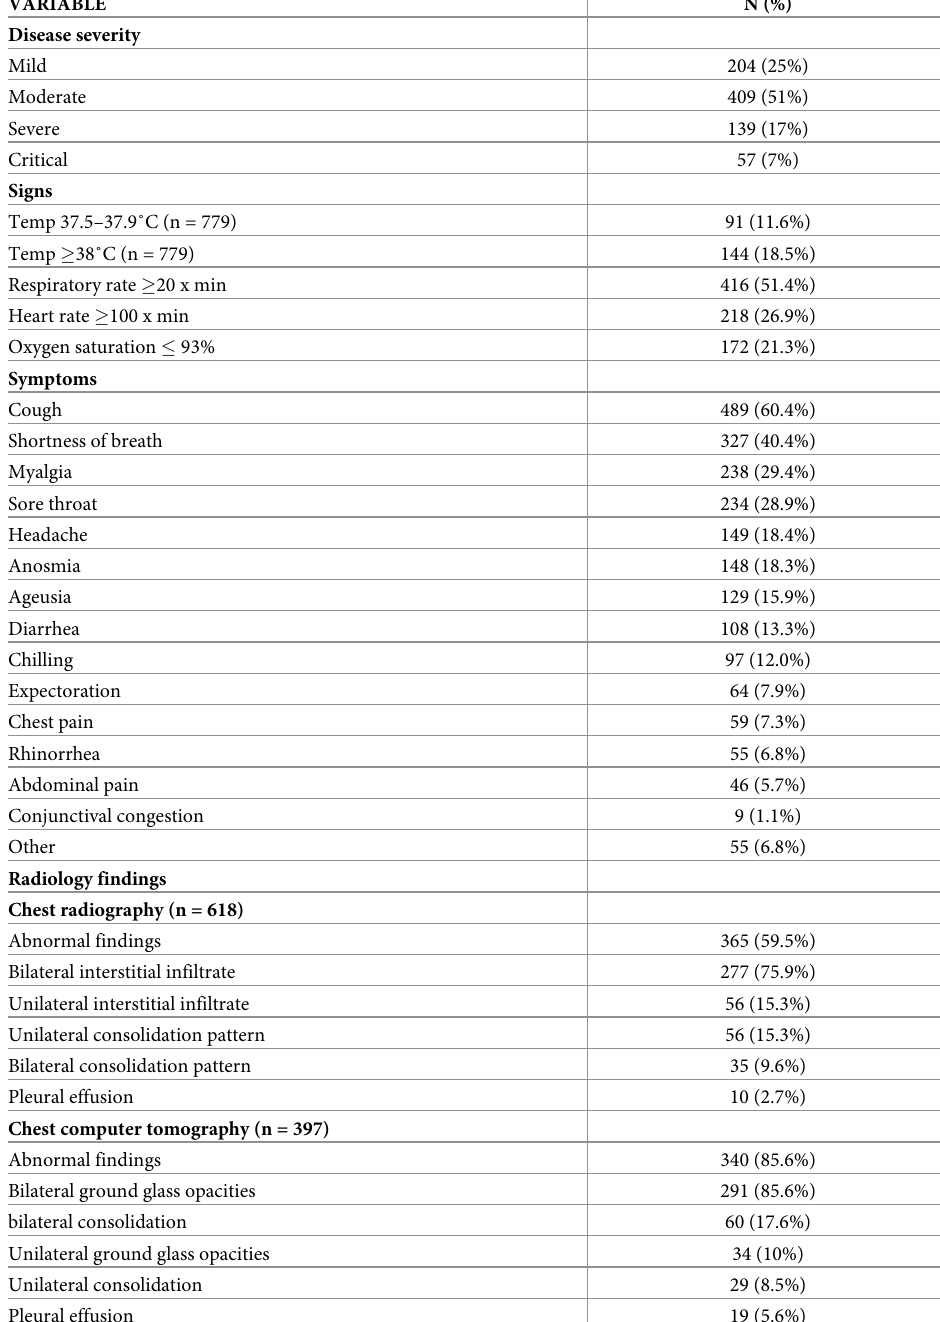
Table 2. Disease severity, signs, symptoms, and radiology findings among 809 hospitalized patients with COVID- 19 in Argentina. VARIABLE N (%) Disease